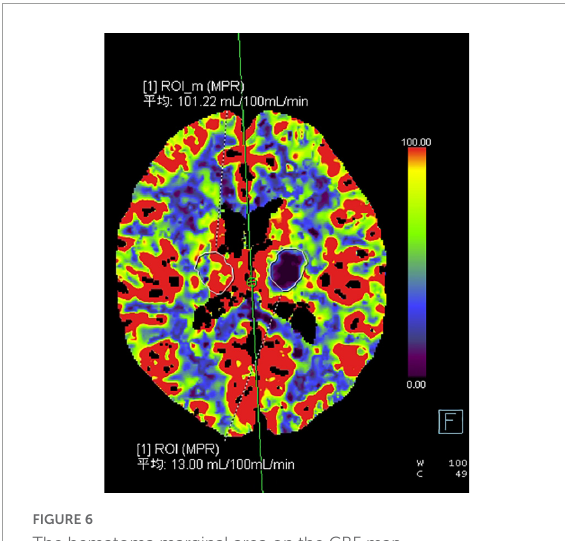
FIGURE6 The hematoma marginal area on the CBF